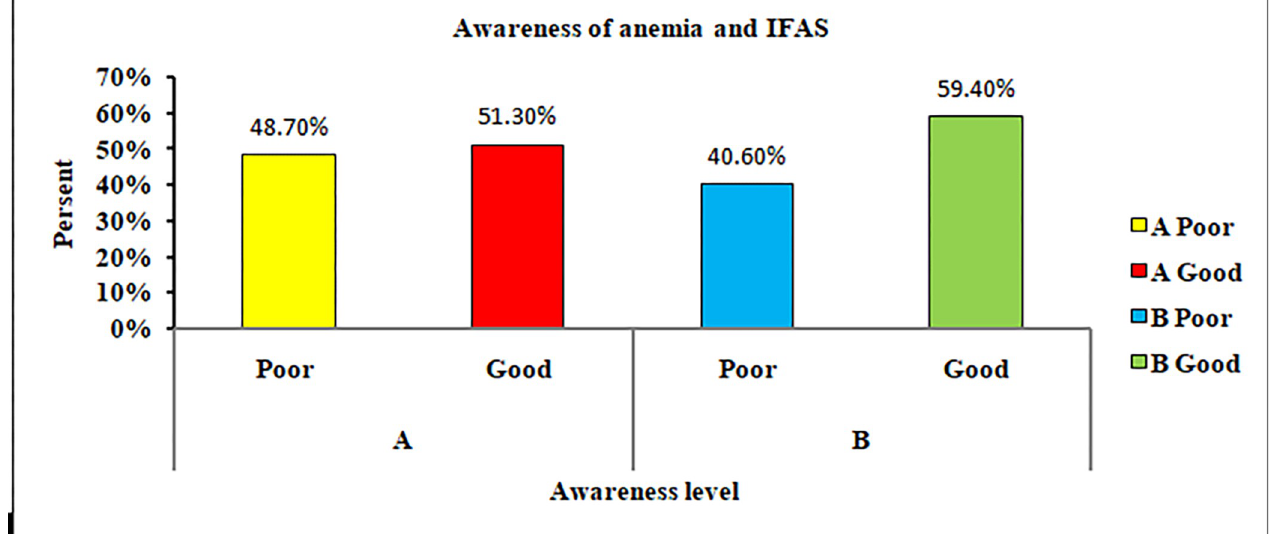
Fig 1. Awareness of anemia and Iron-folate supplementation among pregnant women attending antenatal care in public health facilities at Dire Dawa, Eastern Ethiopia. (A) Explains pregnant women level of awareness of anemia; (B) Explains pregnant women level of awareness of iron folic acid supplements.